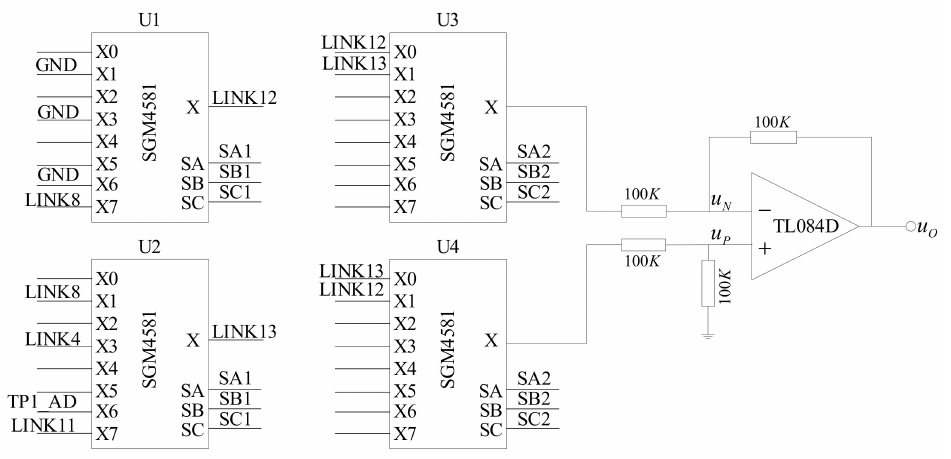
Figure 5. Circuit diagram of the signal acquisition